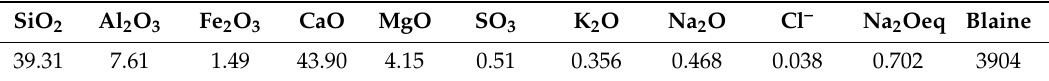
Table 2. Composition of ground granulated blast furnace slag (GGBFS), data supplied by the manufacturer.